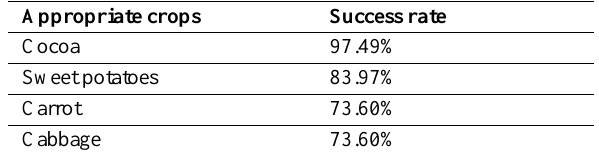
Table 13. Results of the ES in Scenario 2